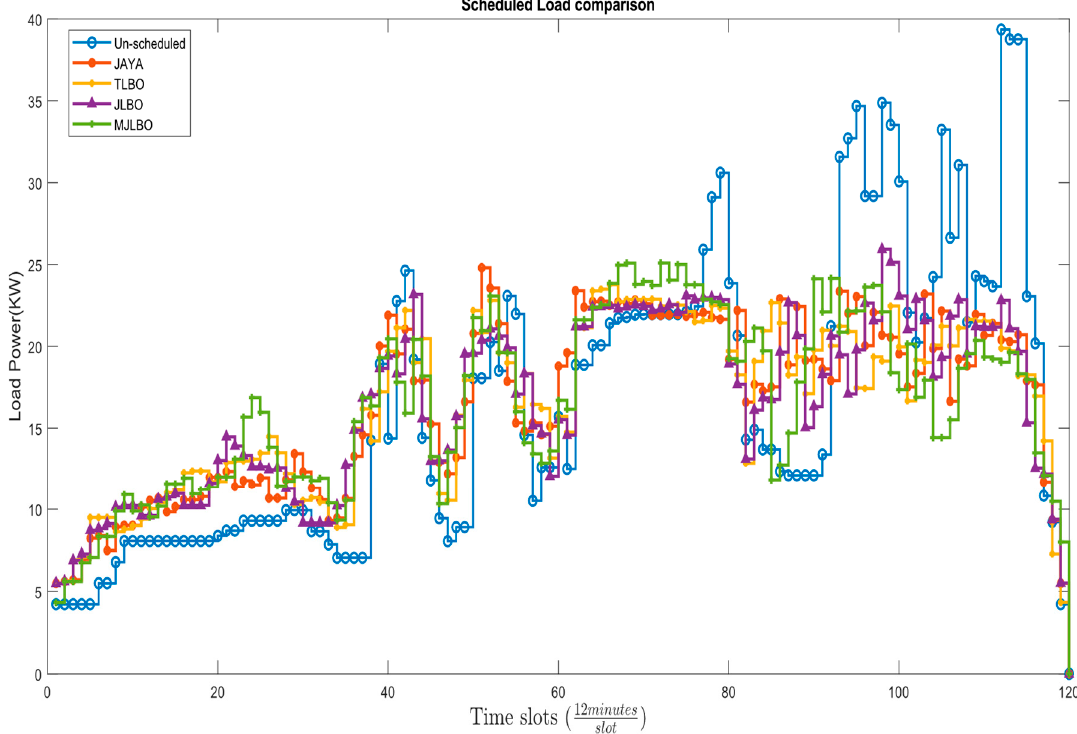
Figure 15. Per-slot load comparison for scheduled and unscheduled load.